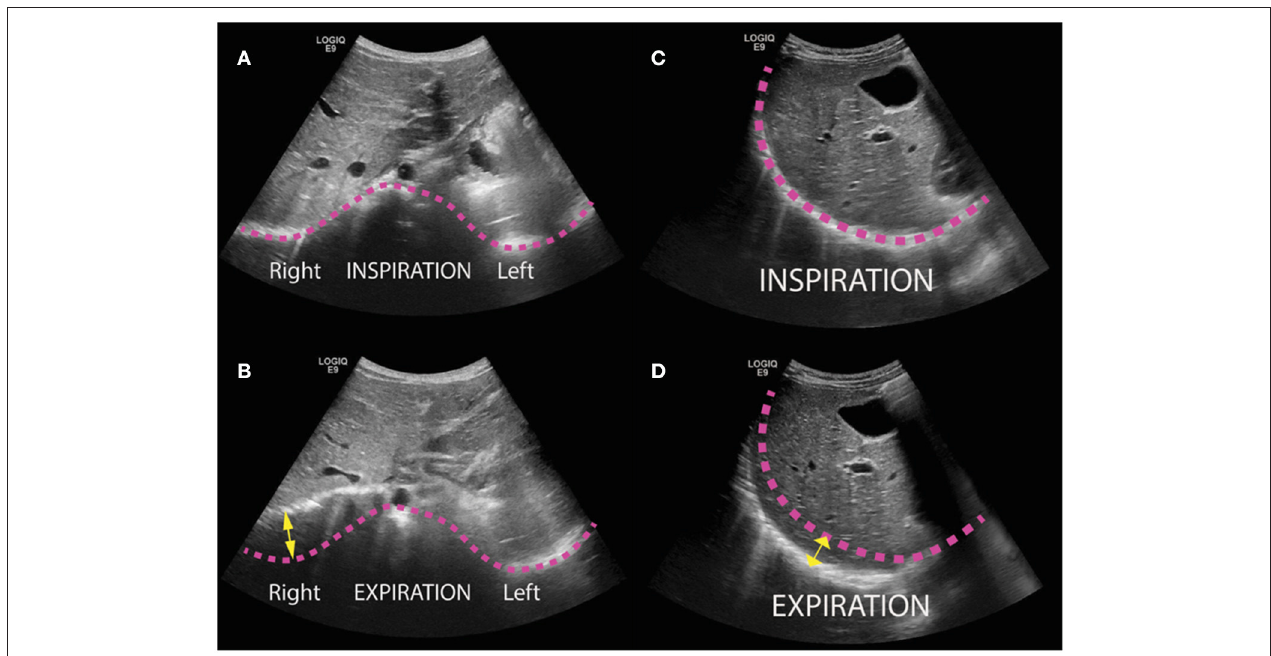
FIGURE 1 | Transthoracic ultrasound images of pediatric patients following repair of congenital diaphragmatic hernia (CDH). Bilateral diaphragms were evaluated in four views (epigastric, anterior, lateral, and posterior) and the greatest craniocaudal excursion of each hemidiaphragm in any view was taken as the maximal excursion. (A,B) Illustrative transverse images obtained in a subxyphoid window from a 12-month-old boy status post repair of left CDH with internal oblique muscle flap at inspiration (A) and expiration (B) . Pink lines trace the contour of the diaphragm in inspiration, and yellow arrow illustrates excursion of the right diaphragm. (C,D) Illustrative sagittal images obtained in a 3-year-old girl status post repair with internal oblique muscle flap at inspiration (C) and expiration (D) .